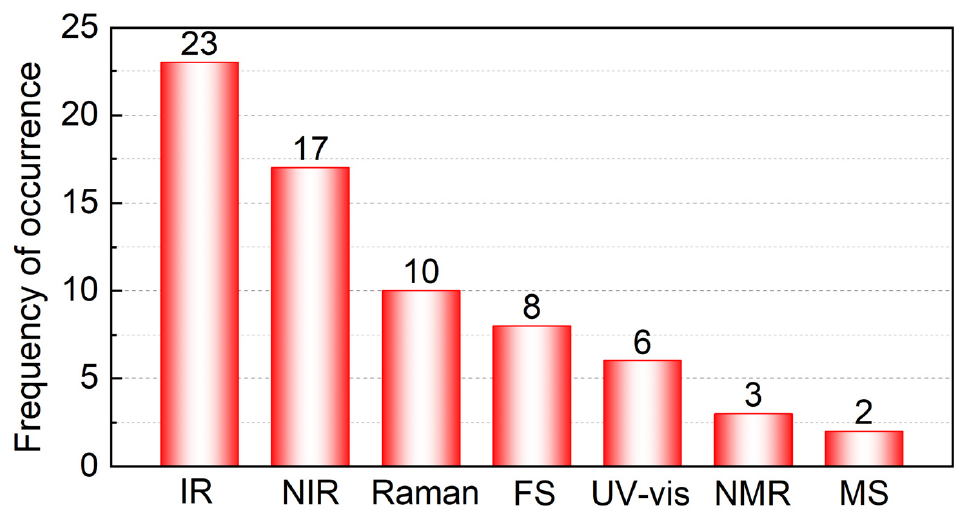
Figure 5. Frequency of occurrence in the literature for different analytical techniques. Table 3. The advantages and disadvantages of different analytical techniques used in the quantitative analysis of edible oil